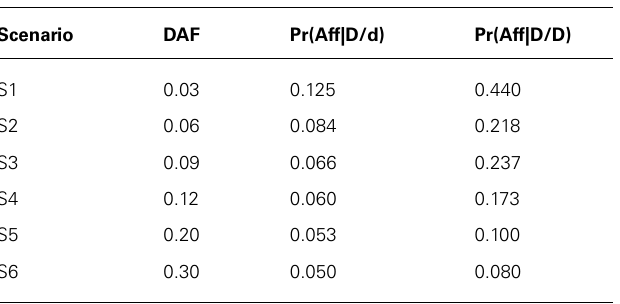
Table 1 | Genetic models for simulated data.